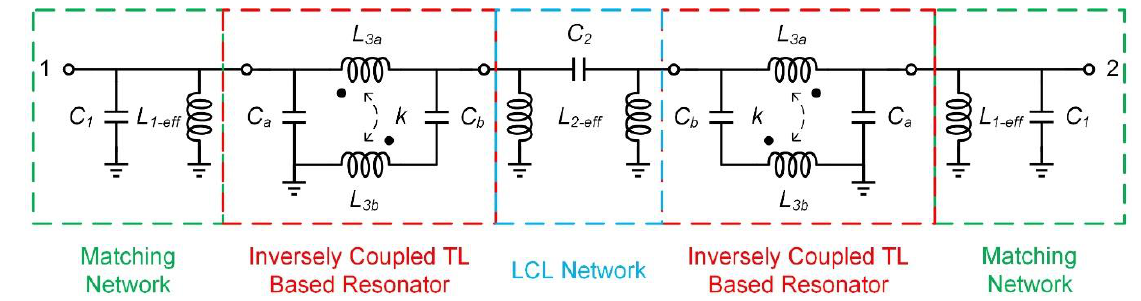
Figure 5. Equivalent circuits for the structure presented in Figure 4.